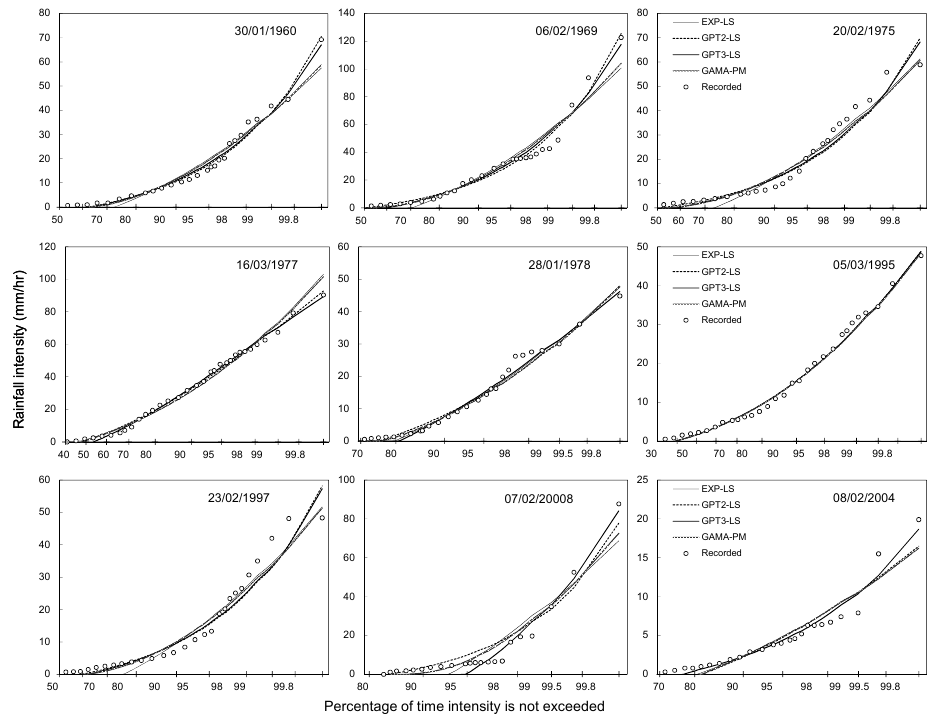
Fig. 3. Fitted cumulative density functions (CDFs) of EXP, GPT2, GPT3 and GAMA for nine events representative of varying daily rainfall depths for Darwin. TDFs were fitted using the LS